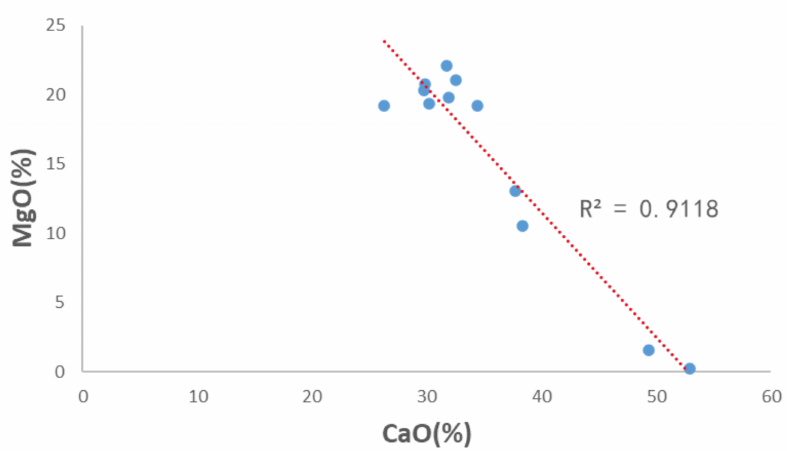
Figure 6. MgO/CaO cross plot of carbonate in M 55 in the Daniudi Gas Field, Ordos